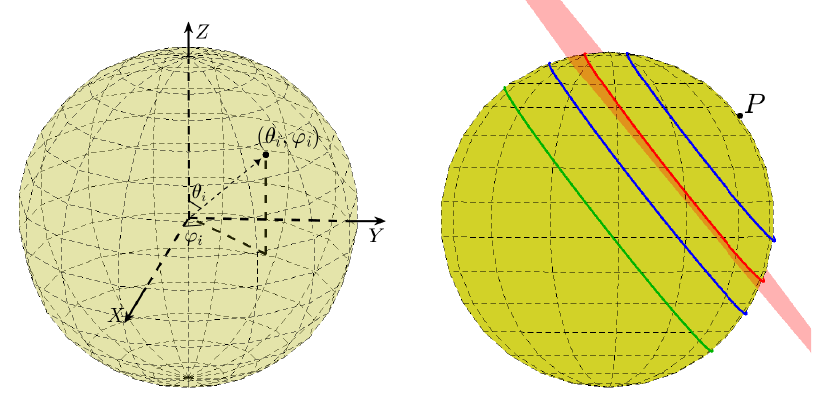
Figure 1. ( Left ) The angular coordinates θ i and ϕ i of a point. ( Right ) The intersection of the sphere with a plane associated with the primary point P is a circle. The intersection of the sphere with each of the associated parallel planes is a different circle with a different radius. For example, the red plane of which the normal direction is determined by point P intersects the sphere at the red circle. The parallel plane that passes through the origin of the sphere is a great circle